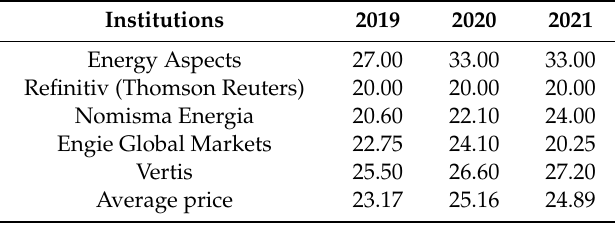
Table 4. Current forecast of prices for EUA allowances for 2018–2021 by five selected institutions (in euros).